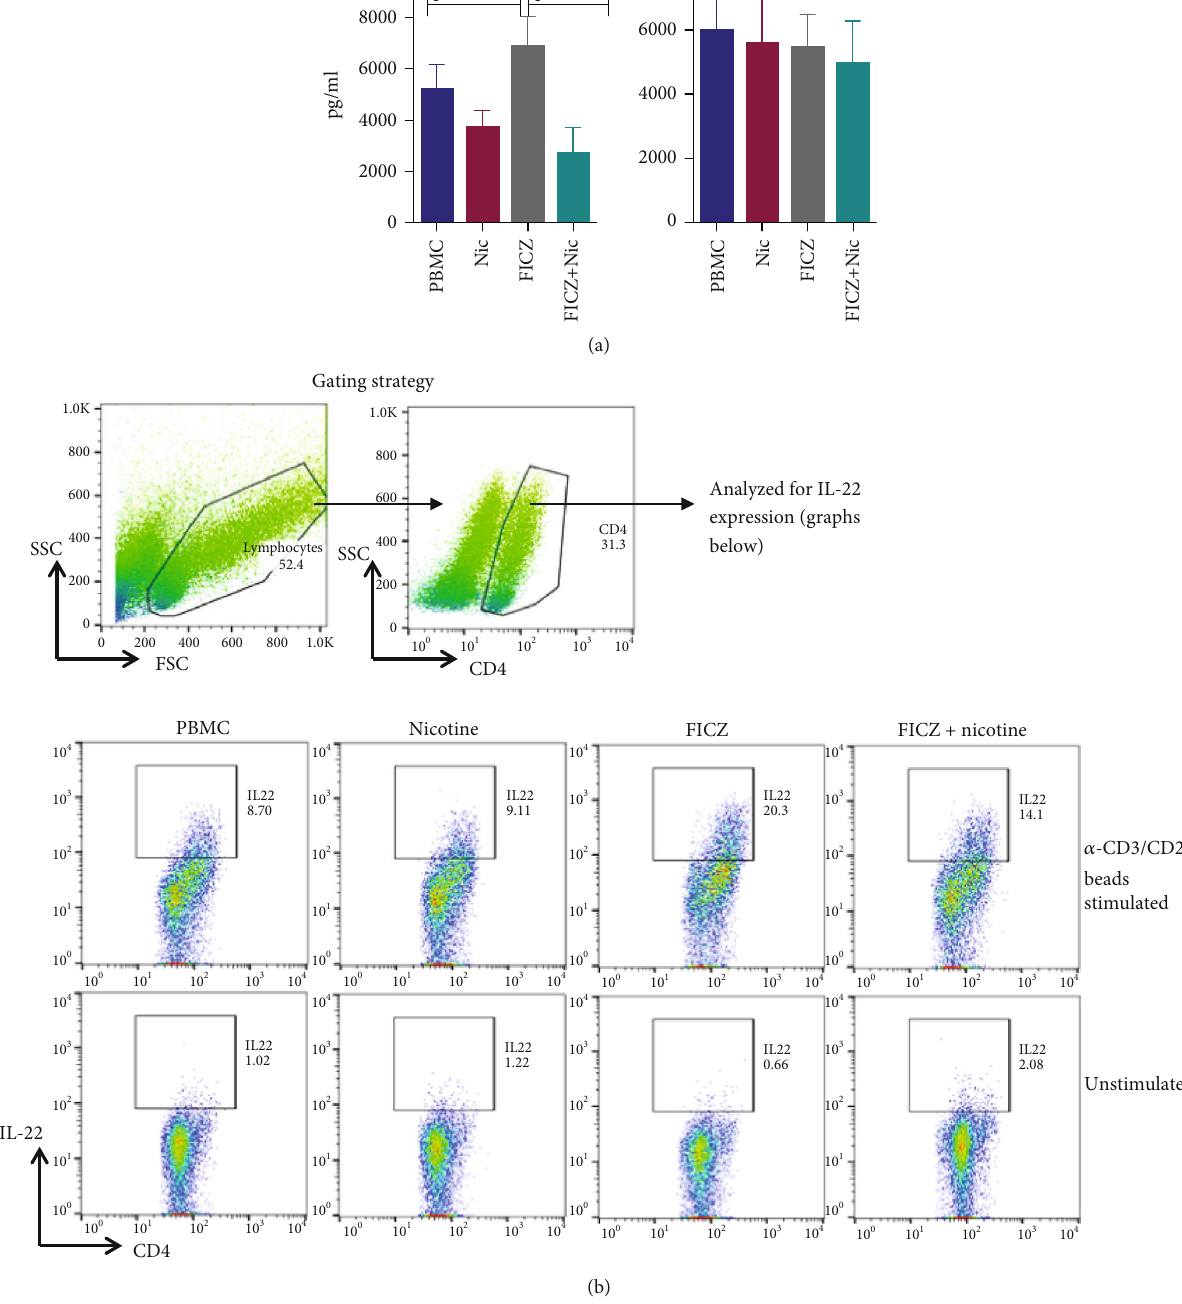
Figure 4: AHR ligand, FICZ, induces IL-22 production in PBMCs from healthy subjects which is suppressed by nicotine. Anti-CD3 and CD28 bead-stimulated PBMCs were exposed to FICZ, nicotine, or both for 5 days. (a) ELISA for IFN- γ and IL-22. Result is presented as the mean ± SD of 4 experiments. ∗ indicates that p value is signi fi cant. (b) Gated CD4 T cells were analyzed for IL-22 expression by intracellular cytokine staining (ICC) using fl ow cytometry. Green dot plots depict the gating strategy. PBMCs without bead stimulation are shown as controls. Data is representative of 4